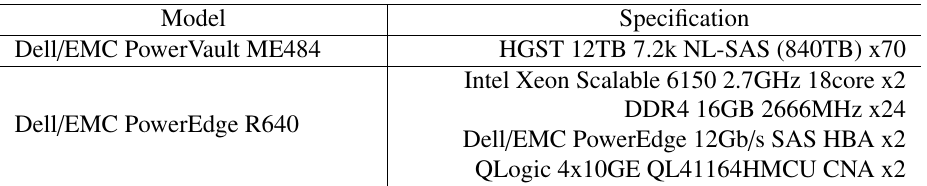
Table 3: The specification of test equipment including high density JBOD enclosure and host server used as the front-end node.